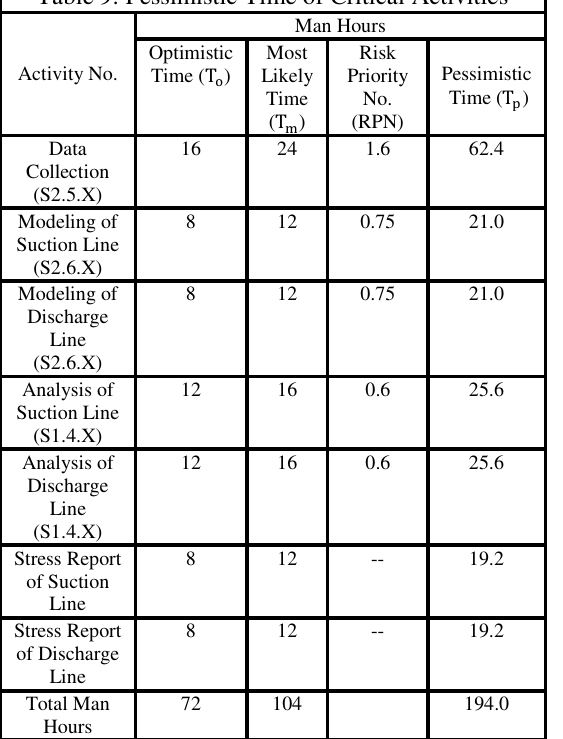
Table 9: Pessimistic Time of Critical Activities Activity No.